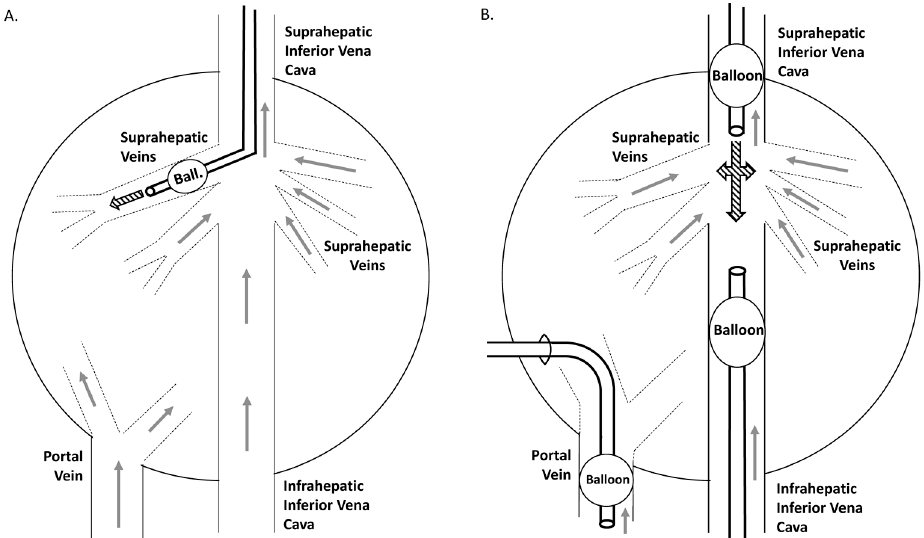
Figure 3. Catheterization strategies for minimally invasive liver hydrofection ‘in vivo.’ Schematic representation of liver venous vasculature and catheters position. Continuous line represents extrahepatic vessels. Gapped lines represent intrahepatic vasculature. Grey arrows indicate the normal blood flow sense. Black thick arrows indicate the sense of hydrodynamic injection.